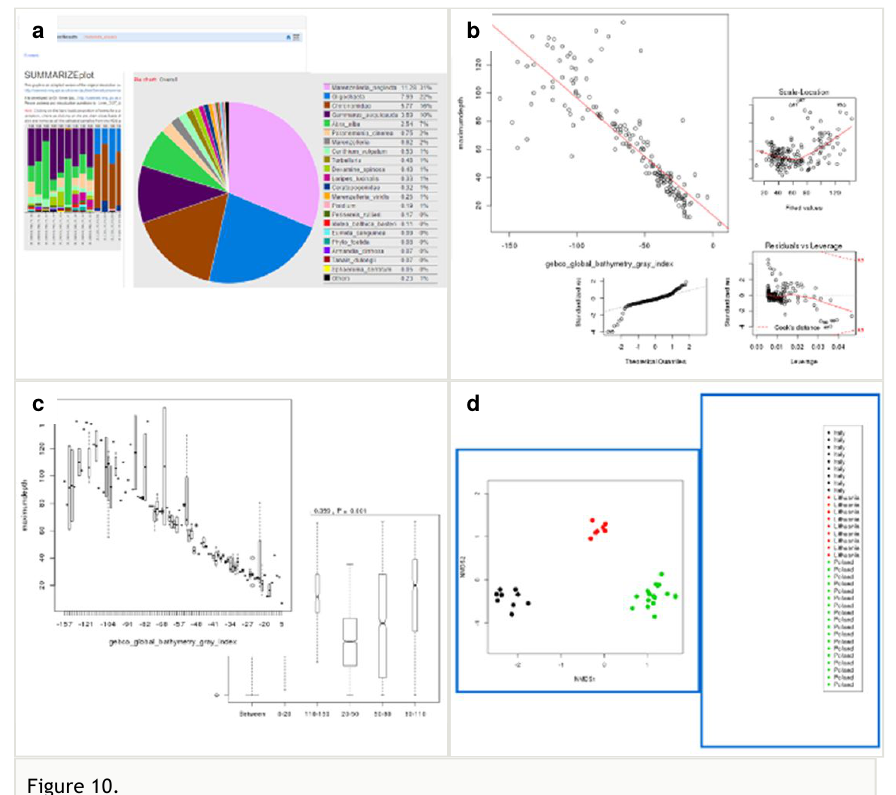
Screen shots showing a few of the graphical results generated by RvLab